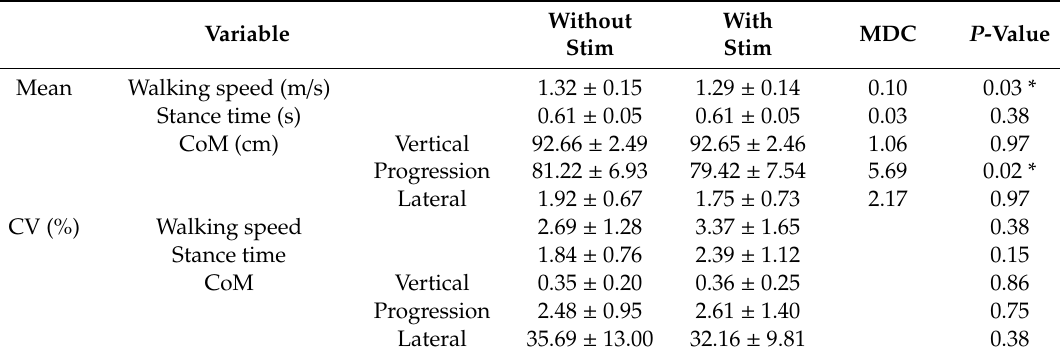
Table 1. Comparison of variables obtained with and without stimulation (stim).